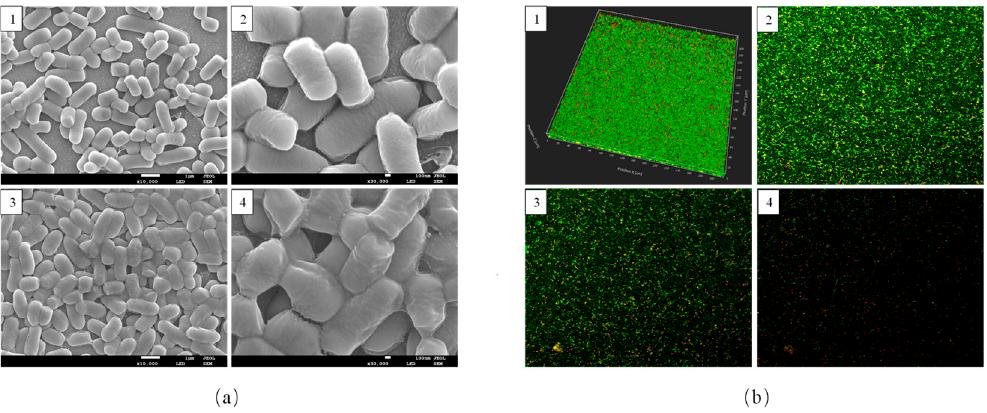
Figure 2. Scanning electron microscopy (SEM) images ( a ) of L. plantarum Y42 in the planktonic ( a1 , a2 ) and biofilm ( a3 , a4 ) forms. The images were taken at 10,000× ( a1 , a3 ) and 30,000× ( a2 , a4 ) magnification, respectively. CLSM images of L. plantarum Y42 biofilms ( b ). 3D images of biofilm stained by SYTO 9 (live cells, green) and PI (dead cells, red) ( b1 ). The distribution of live and dead cells at different heights, where ( b2 – b4 ) were the surface, middle, and bottom positions, respectively.